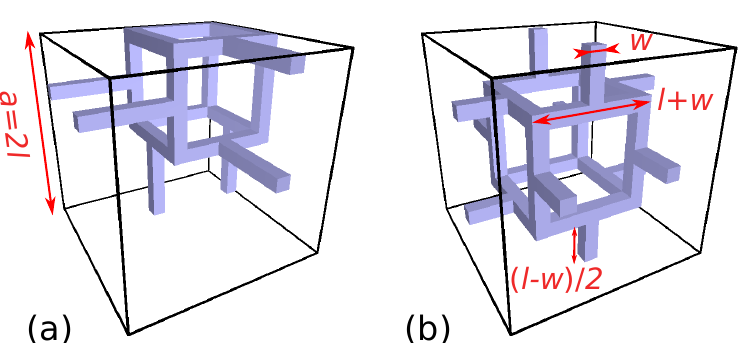
Figure 4. Two representations of the unit cell of the Gibson–Ashby structure. In ( a ), the wire cube is located at a corner of the cubic cell, in ( b ) it is centered in the cell. When heat source and drain are contacted to the top and bottom faces of the unit cell, the layer in ( b ) has a symmetry plane at half thickness whereas the layer ( a ) does not. The effective conductivity values of the two structures differ. Another way to have a structure with a symmetry plane at half layer is to move the structure ( b ) by l = a /2 in the vertical direction. The plane at half thickness will then bisects the vertical stunts. The effective conductivity will be the same as for structure ( b